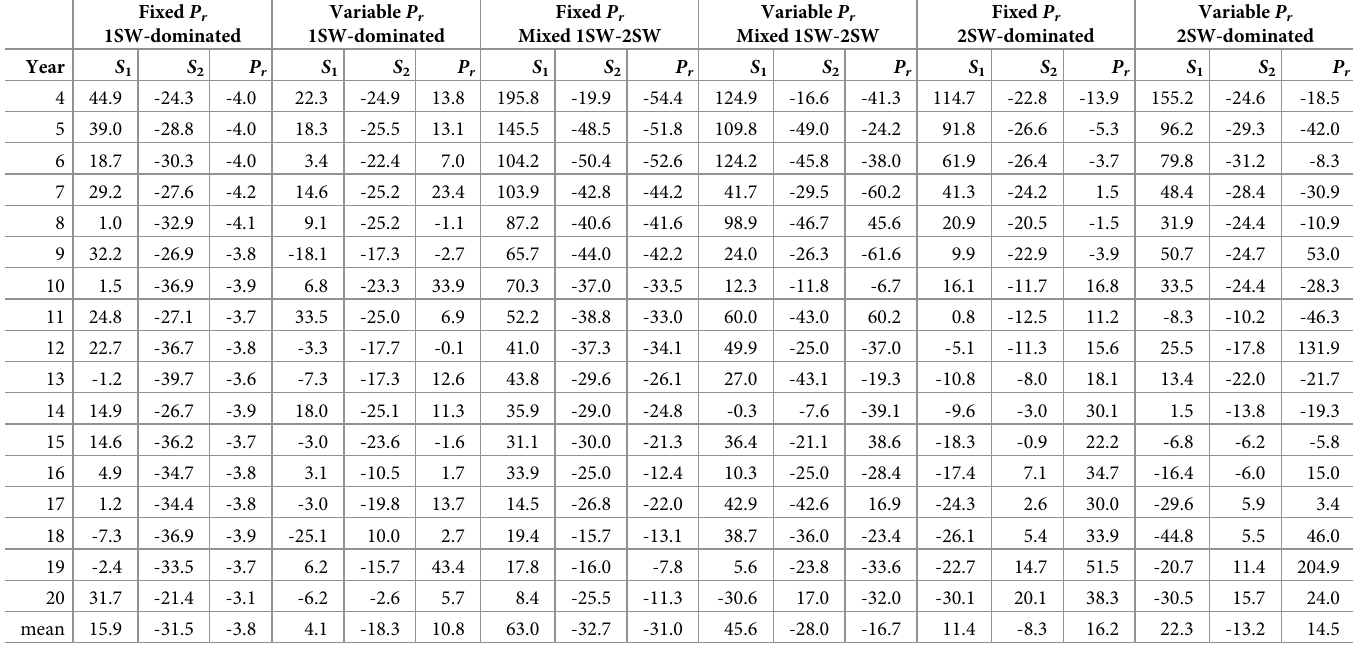
Table 3. Bias of estimates (shown as percentage difference) for estimated S 1 , S 2 , and P r values across years and scenarios. Fixed P r